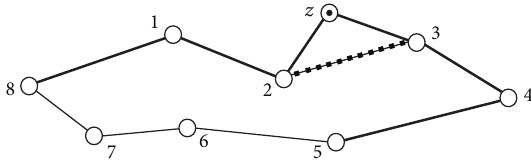
Figure 1: Example of insertion of 𝑧 into 2-subtour: Ins (𝑧, 2,2, (1,. . ., 8)) = (8,1, 2,𝑧, 3, 4, 5) .